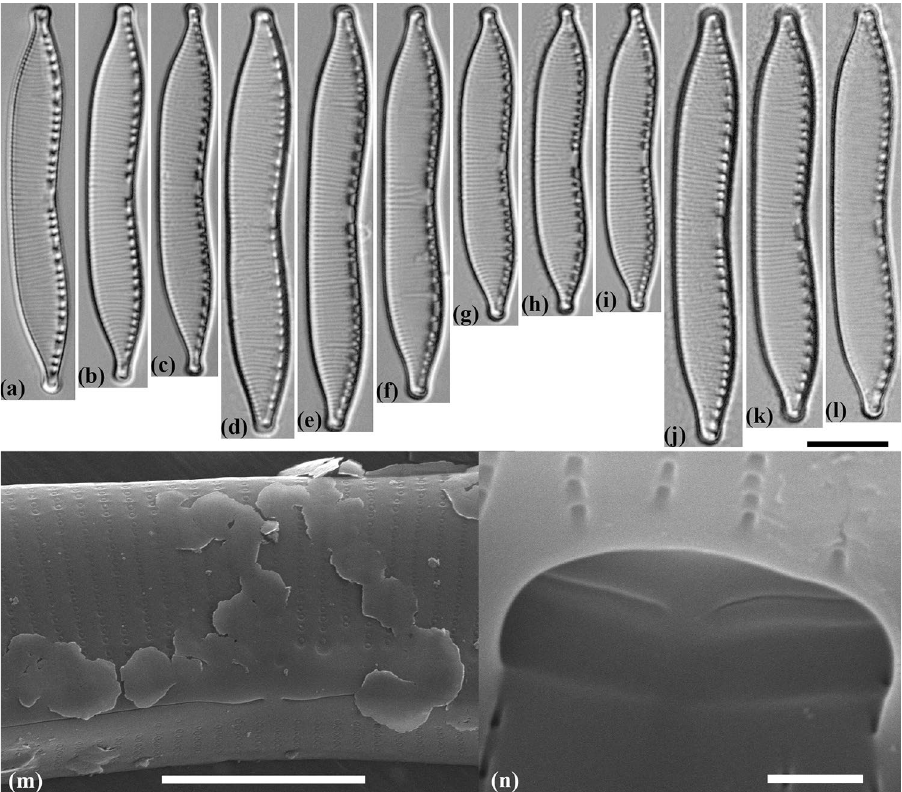
Figure 3. Valve morphology of the different strains of Hantzschia abundans . ( a – l ) Light micrographs. ( a – c ) H. abundans MZ–BH1. ( d – f ) H. abundans MZ–BH2. ( g – i ) H. abundans MZ–BH6. ( j – l ) H. abundans